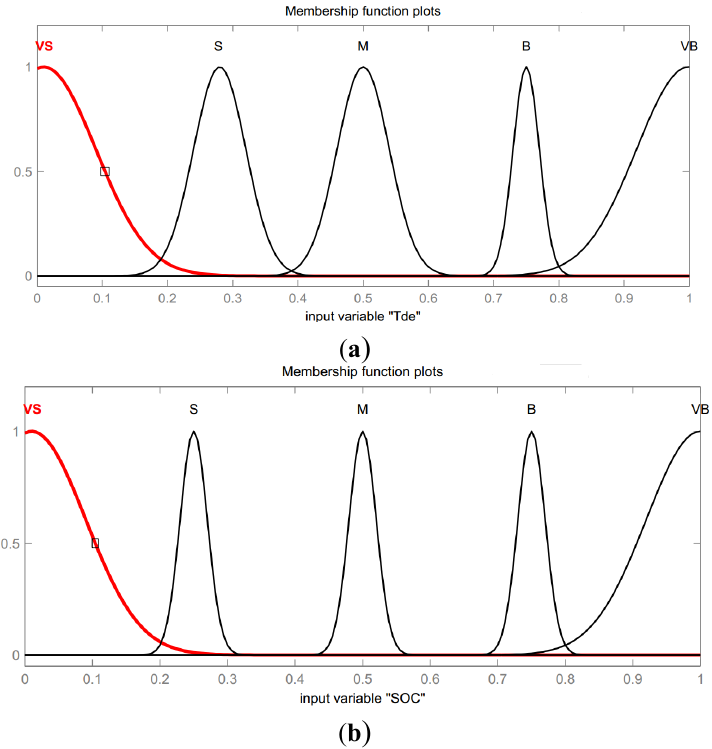
Figure 5. ( a ) Initial membership functions of